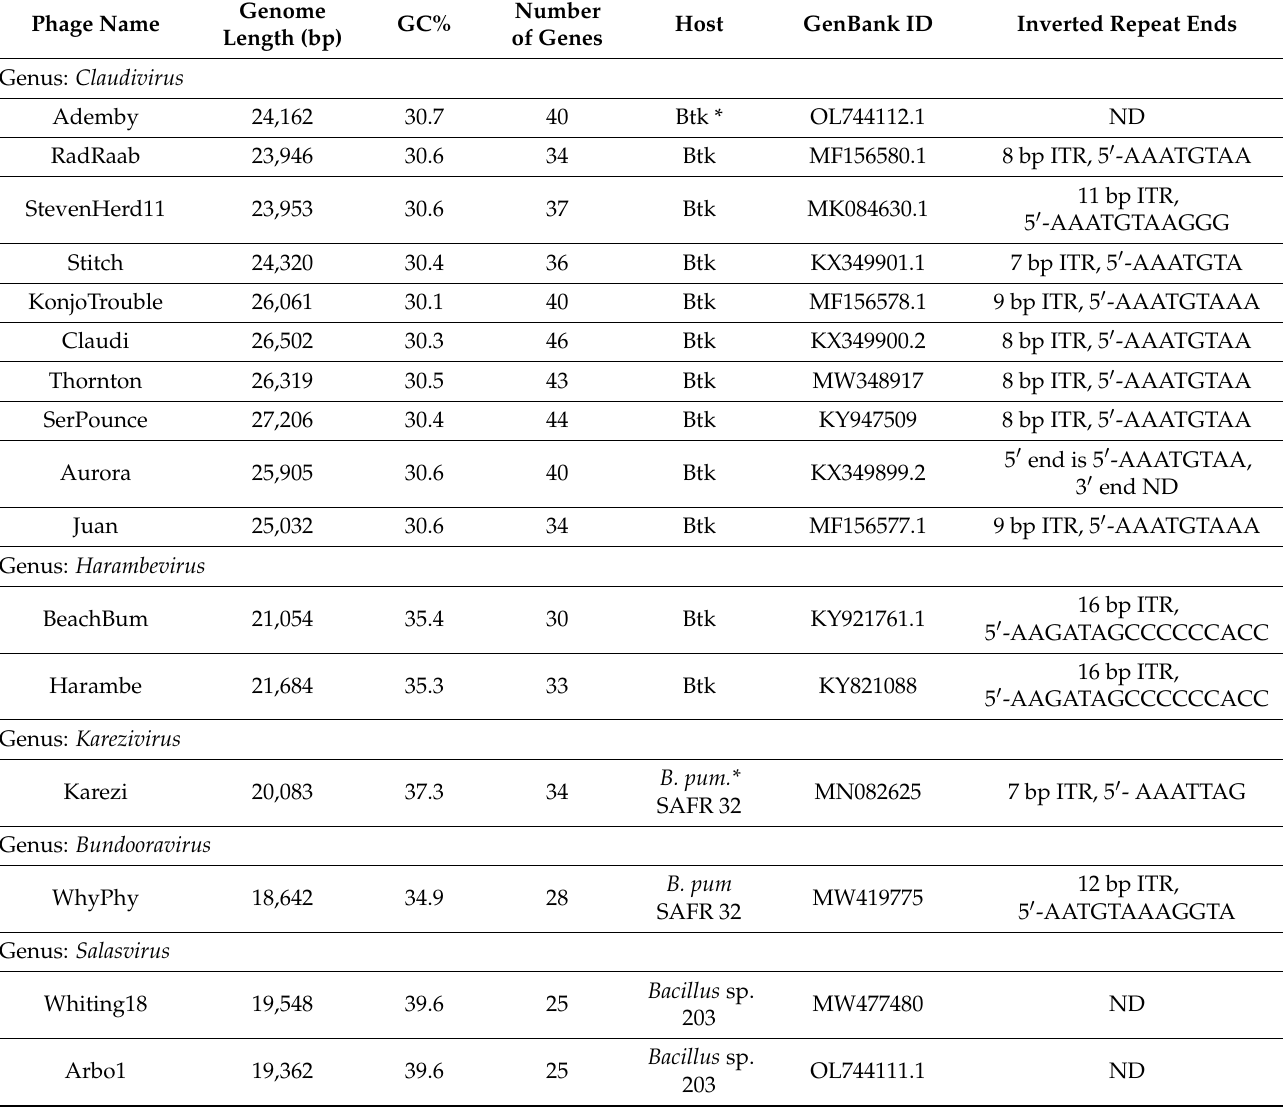
Table 1. Genome features of 16 Bacillus